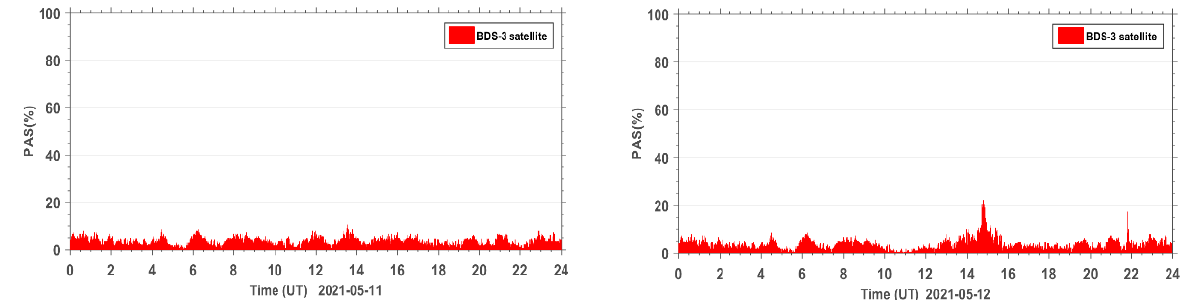
Figure 7. Time series of PAS for BDS3 sites worldwide during the reference day (11 May 2021) and the geomagnetic storm day (12 May 2021).